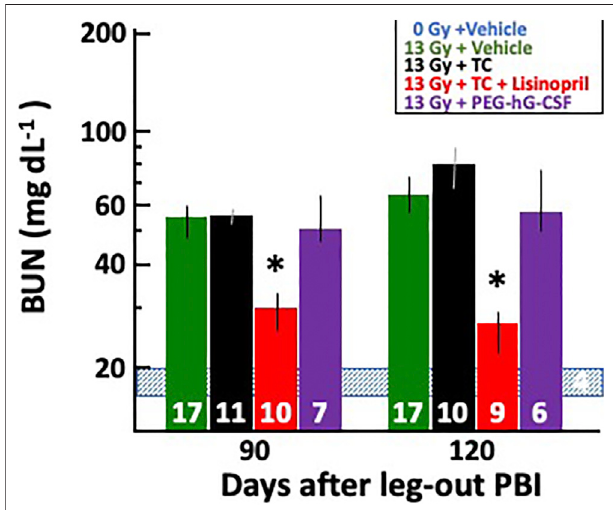
FIGURE 7 | Mitigation of radiation nephropathy after 13 Gy leg-out PBI by lisinopril. The graph shows medians and 20 – 80% ranges for blood urea nitrogen (BUN in mg dL − 1 ) in rats at 90- and 120-days post irradiation. Asterisks (*) represent p < 0.05 as compared to irradiation only, irradiation with triple combination (TC) and irradiation with PEG-hG-CSF groups at the corresponding times show increased BUN levels. The normal BUN for non-irradiated rats ranges between 18 and 21 mg dl − 1 and is represented by the shaded, horizontal blue bar. Numbers in the bars represent N in each group. The decrease in N ’ s between 90- and 120-days post-irradiation were not due to radiation nephropathy; therefore, they were not given a value of 120 mg dl − 1